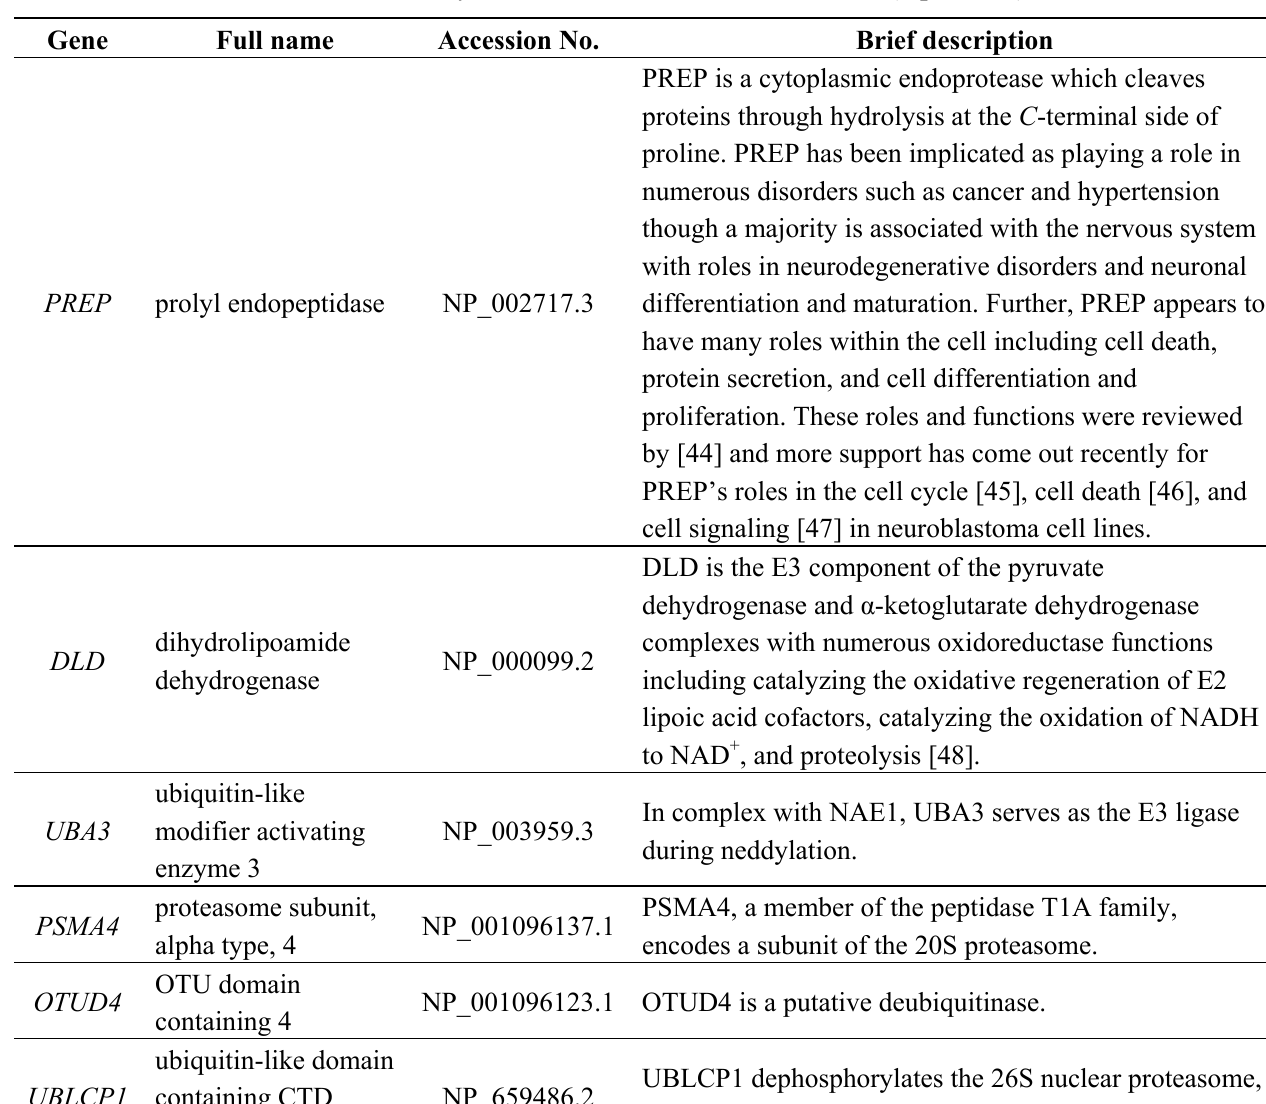
Table 2. Proteolysis/Post translational modification (7